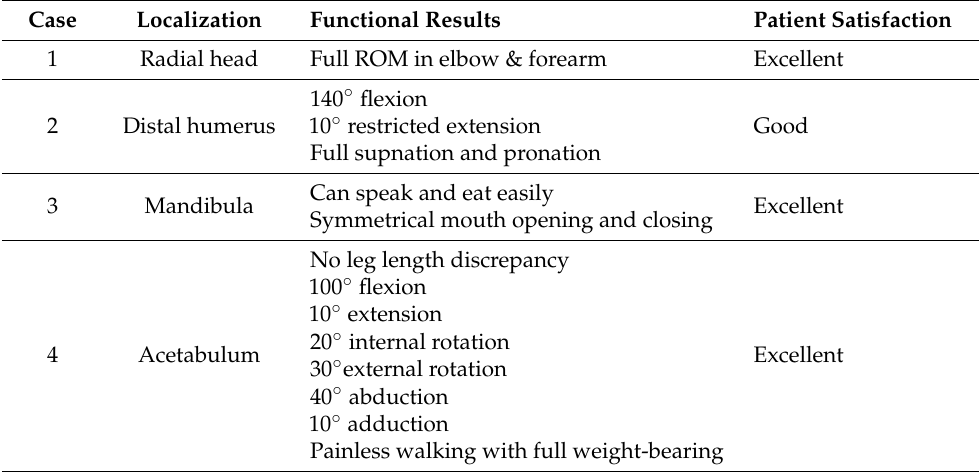
Table 2. Functional results and patient satisfaction of the four clinical cases.